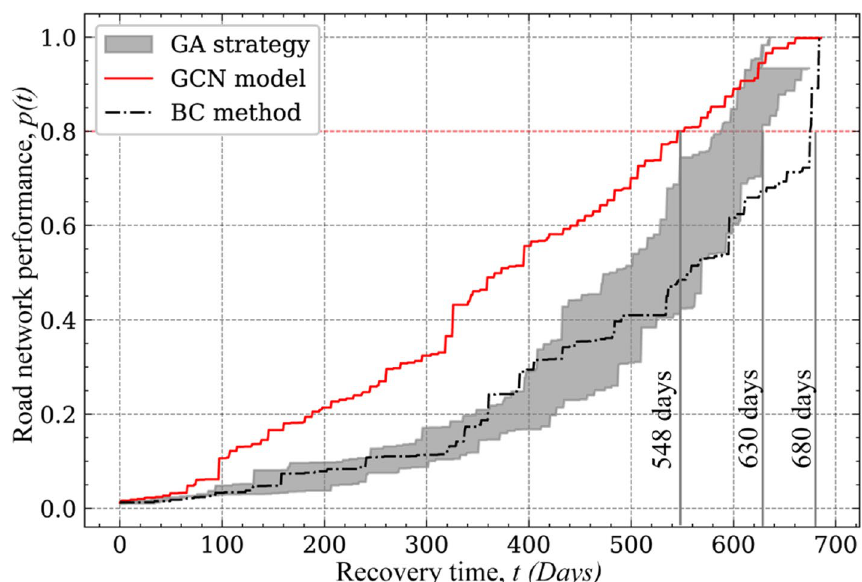
Fig. 9 Comparison of the development of post-earthquake system performance by repairing sequences determined by different decision methods, (GA is short for genetic algorithm, GCN is the proposed method, and BC is short for betweenness